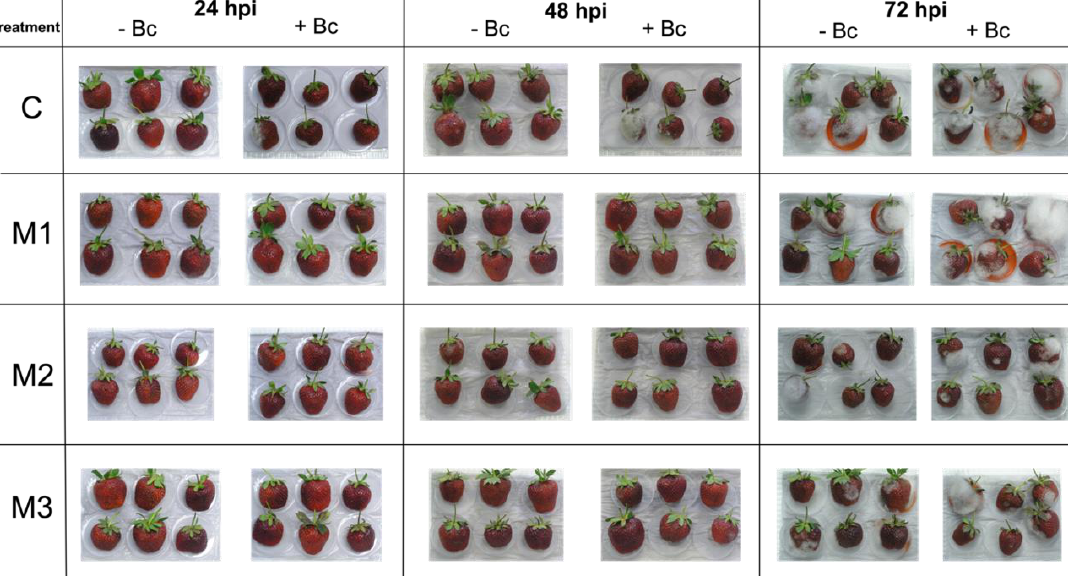
Figure 1. Evolution of postharvest necrotrophic fungi (including gray mold) incidence on representative strawberry ( Fragaria × ananassa ‘Camarosa’) fruits belonging to the di ff erent treatments performed in the present research. Each group of fruits subjected to di ff erent methyl jasmonate (MeJA) treatments during fruit development (C, M1, M2, and M3) were inoculated by injecting 20 µ L of the Botrytis cinerea conidia suspension ( + Bc) or distilled water ( − Bc) with a sterile syringe. Fruits were maintained in humidity chamber at 20 ◦ C up to 72 h post-inoculation (hpi). Gray mold incidence in + Bc and − Bc fruits was recorded at 24, 48 and 72 hpi. For experimental details, see the Materials and Methods section. Table 1. Incidence (%) of gray mold in control (C), and methyl jasmonate (MeJA)-treated strawberry ( Fragaria × ananassa ‘Camarosa’) fruits (M1, M2, M3 treatments) inoculated with Botrytis cinerea conidia ( + Bc) or water ( − Bc). For experimental details, see the Materials and Methods section. +Bc Treatment